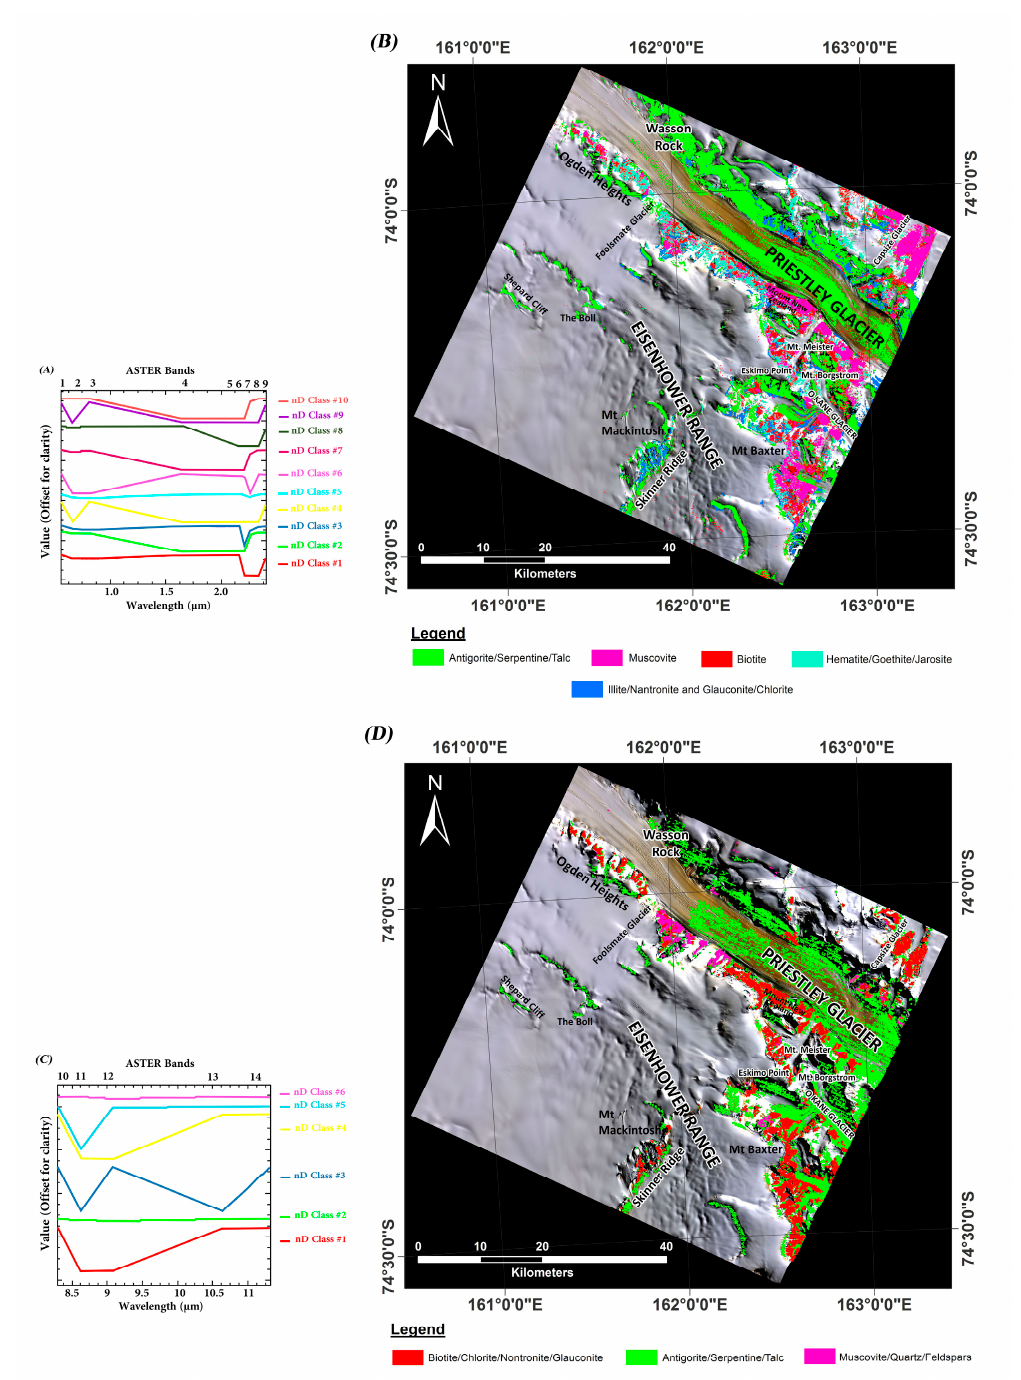
FIG 7 Figure 7. ( A ) Endmember spectra extracted from ASTER VINR+SWIR bands using the n-Dimensional analysis technique for the Priestley Glacier. ( B ) MTMF classification mineral maps derived from MF score images (VINR+SWIR bands) for the Priestley Glacier scene. ( C ) Endmember spectra extracted from ASTER TIR bands using the n-Dimensional analysis technique for the Priestley Glacier. ( D ) MTMF classification mineral maps derived from MF score images (TIR bands) for the Priestley Glacier